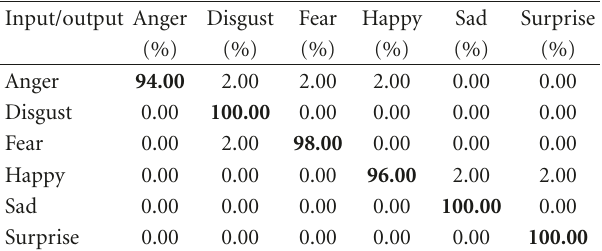
Table 5: Confusion matrix of the LDA classifier for the automati- cally selected